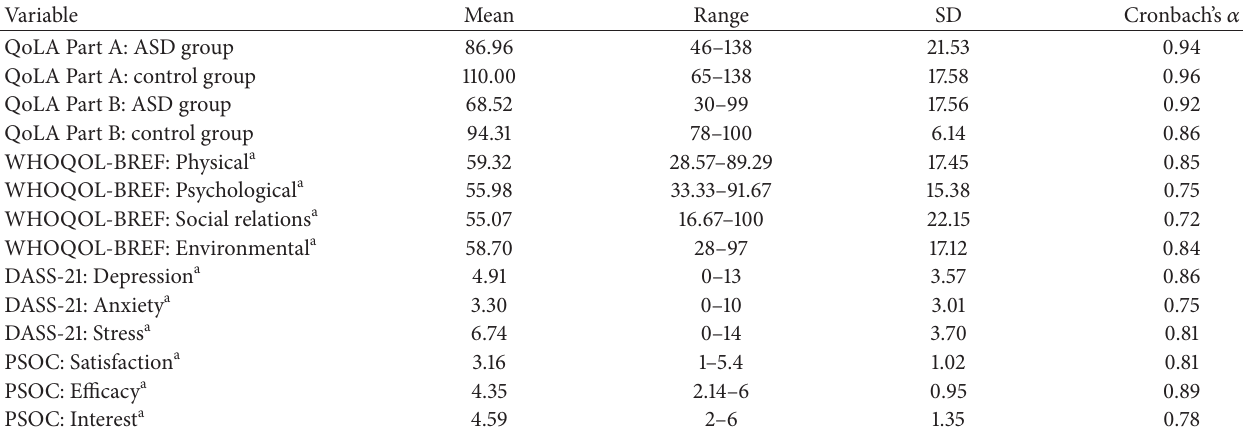
Table 3: Descriptive statistics and internal consistency coefficients for all measures